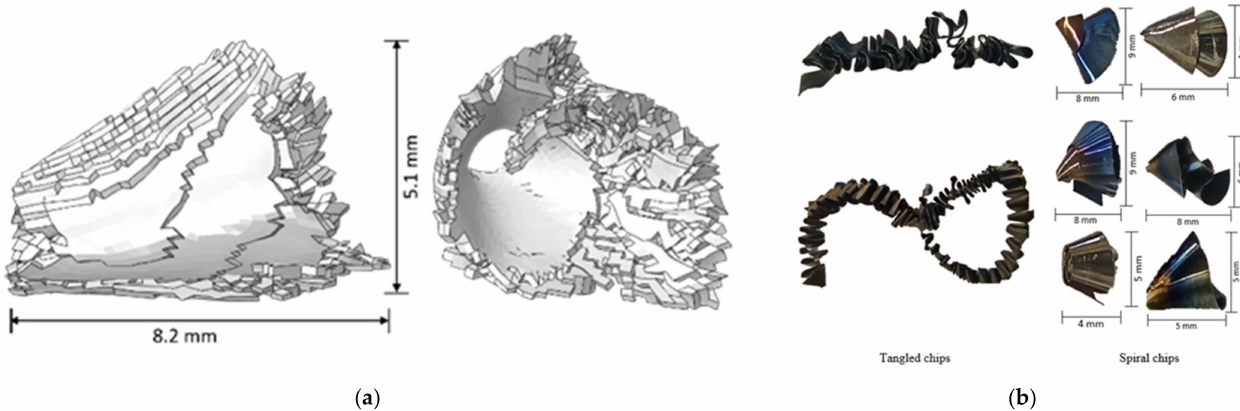
Figure 7. Lateral and front views of the formed chip with a feed of 0.64 mm/rev and a cutting speed of 427.5 m/min in the simulation ( a ) and chips obtained from the experiment ( b